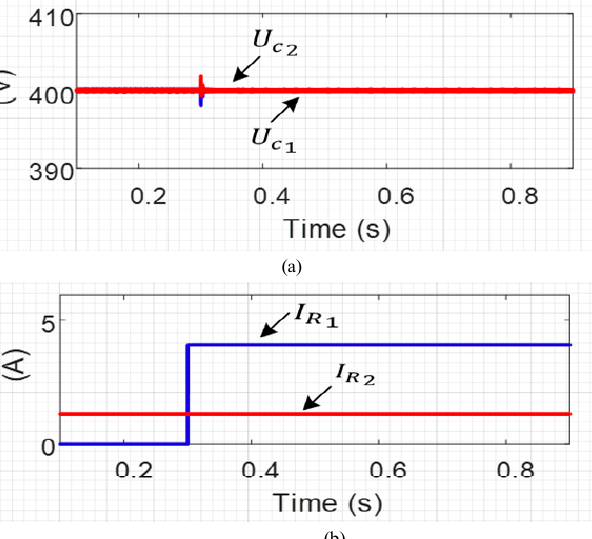
Figure 17. Experimental results under transient load conditions when I R 1 is increasing. ( a ) Output voltages. ( b ) Load currents.